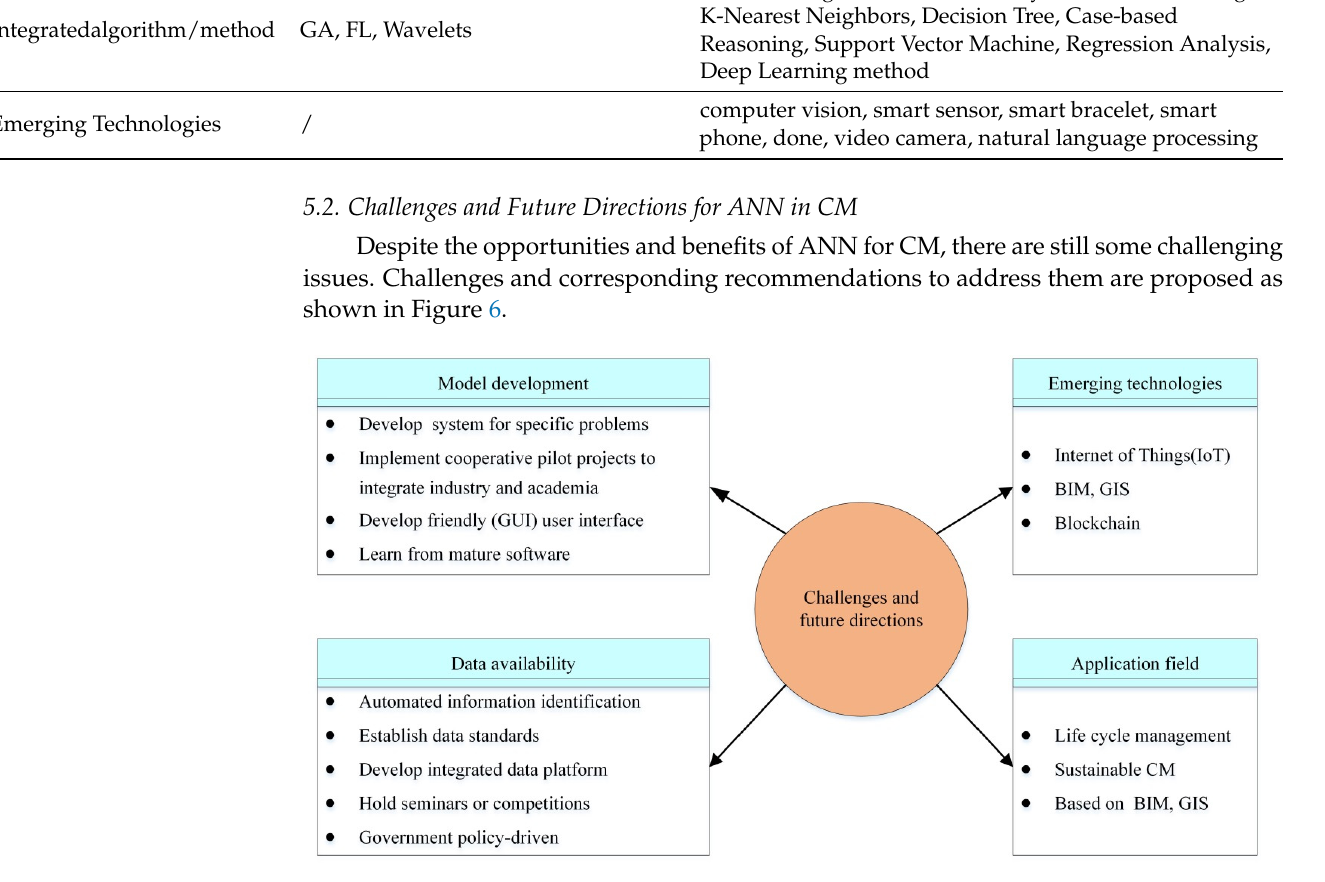
Figure 6. Challenges and future